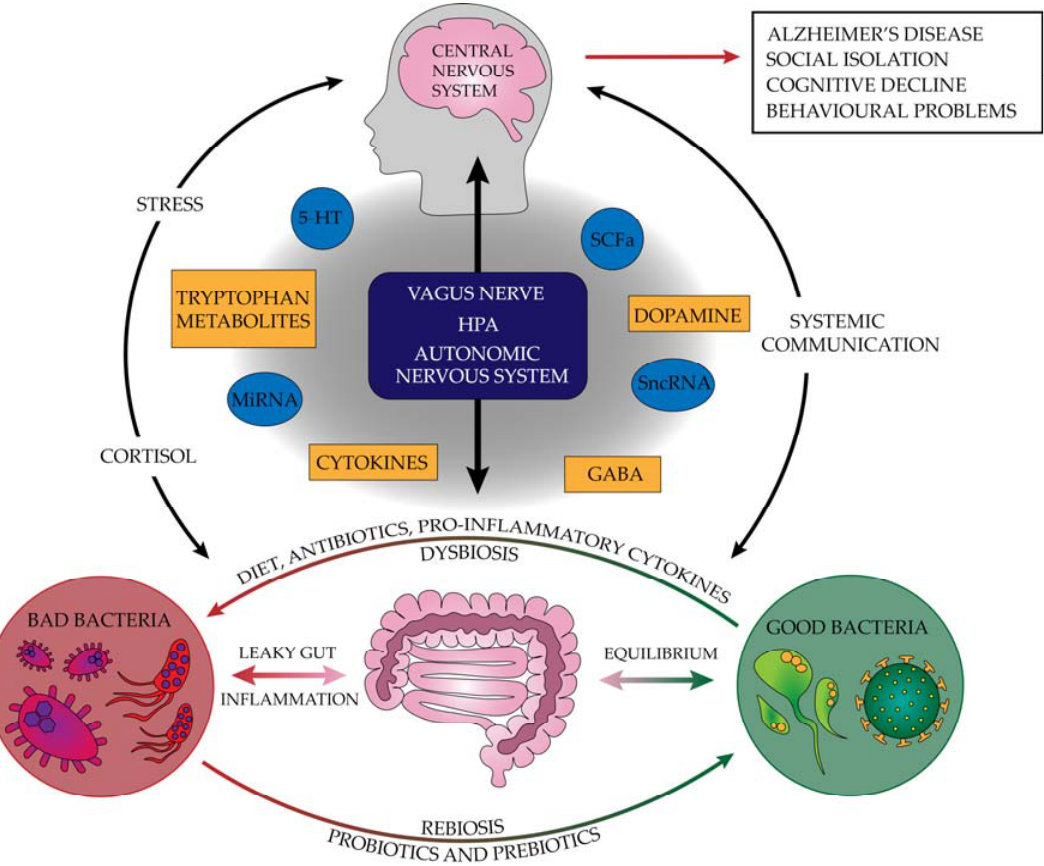
Figure 2. The pathogenesis of neurodegenerative diseases and factors protecting against their incidence that inhibit their progression (5-HT—serotonin, GABA—gamma-aminobutyric acid, HPA— hypothalamus–pituitary–adrenal, miRNA—microRNA, SCFAs—short-chain fatty acids, sncRNA— small non ‐ coding RNA).